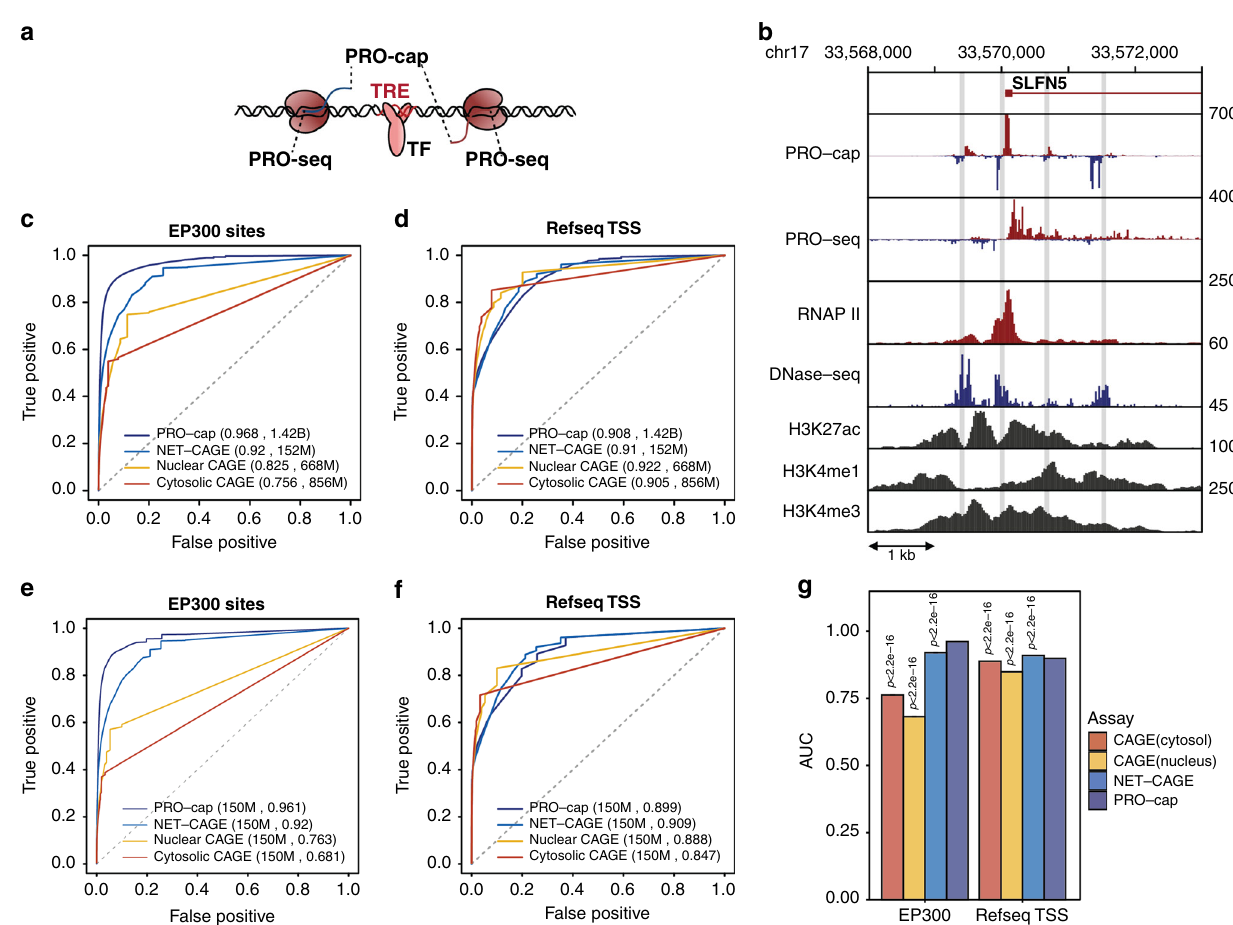
Fig. 1 PRO-cap identi fi es tTREs with high resolution and sensitivity. a Schematic of bidirectional transcription at tTREs. PRO-cap measures nascent- capped-RNA levels and identi fi es the precise TSS positions (5 ′ end); PRO-seq measures the 3 ′ end of RNAs associated with transcriptionally-engaged polymerase. b Transcription and chromatin marks at the SLFN5 locus. PRO-cap, PRO-seq, and DNase-seq data are derived from the YRI LCLs, RNAP II, H3K27, H3K4me2 and H3K4me3 ChIP-seq data are from ENCODE ’ s LCL, GM12878. Shaded regions indicate PRO-cap-identi fi ed tTREs. c Receiver operating characteristic (ROC) plots of PRO-cap, CAGE from nuclear and cytoplasmic poly-A selected RNA, and NET-CAGE at EP300 bound enhancers ( n = 18,956). Each pro fi le comes from an aggregate of all replicates. NET-CAGE data is for GM12878 and CAGE data is from ENCODE Riken GM12878. d As in c for annotated gene promoters ( n = 12,272). e As in c , except using downsampling of aggregate datasets to match read counts to 150 million reads per method ( n = 20 for each dataset). f As in e for annotated gene promoters. g Mean area under ROC curves ( e and f , n = 20 downsamplings for each dataset). P -values for all tests compared to PRO-cap are by two-sided Welch t-test for the mean AUC for EP300 sites and Refseq promoters. Source data are provided as a Source Data fi